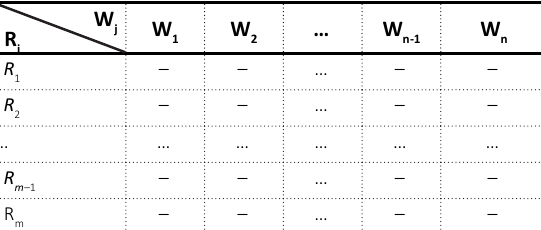
The interval of equal distribution of rows